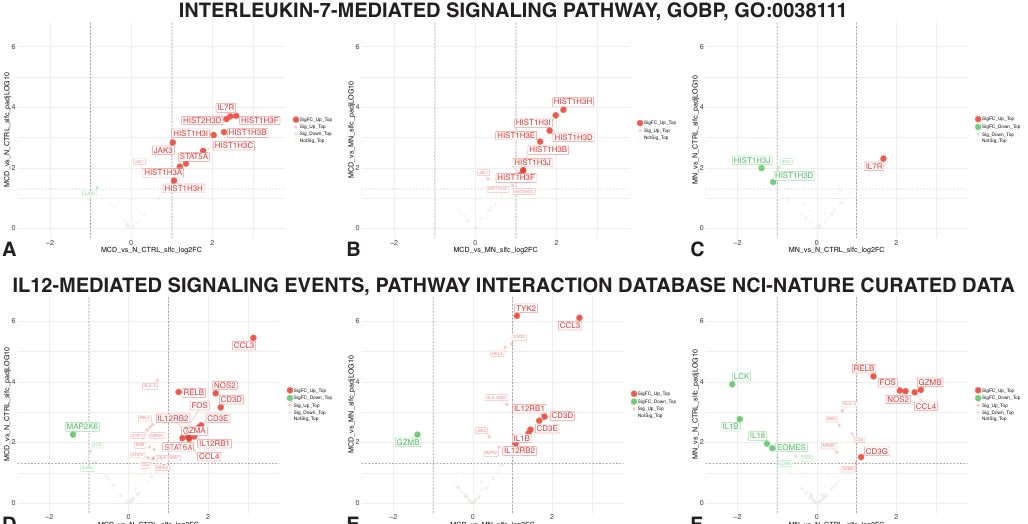
Figure 5. Volcano plots of IL-7 and IL-12-mediated signaling member genes. For the IL-7-mediated signaling pathway: ( A ) MCD vs. N_CTRL, ( B ) MCD vs. MN and ( C ) MN vs. N_CTRL. For the IL-12-mediated signaling pathway: ( D ) MCD vs. N_CTRL, ( E ) MCD vs. MN and ( F ) MN vs. N_CTRL. The volcano plots display all member genes of the respective pathway. Genes yielding adjusted p -values of <0.05 (above the horizontal dashed line) were labeled, and if they also passed the shrunk fold change criterion of >2 for upregulation or < − 2 for downregulation (vertical dashed lines), they were highlighted further via increased size and saturation.